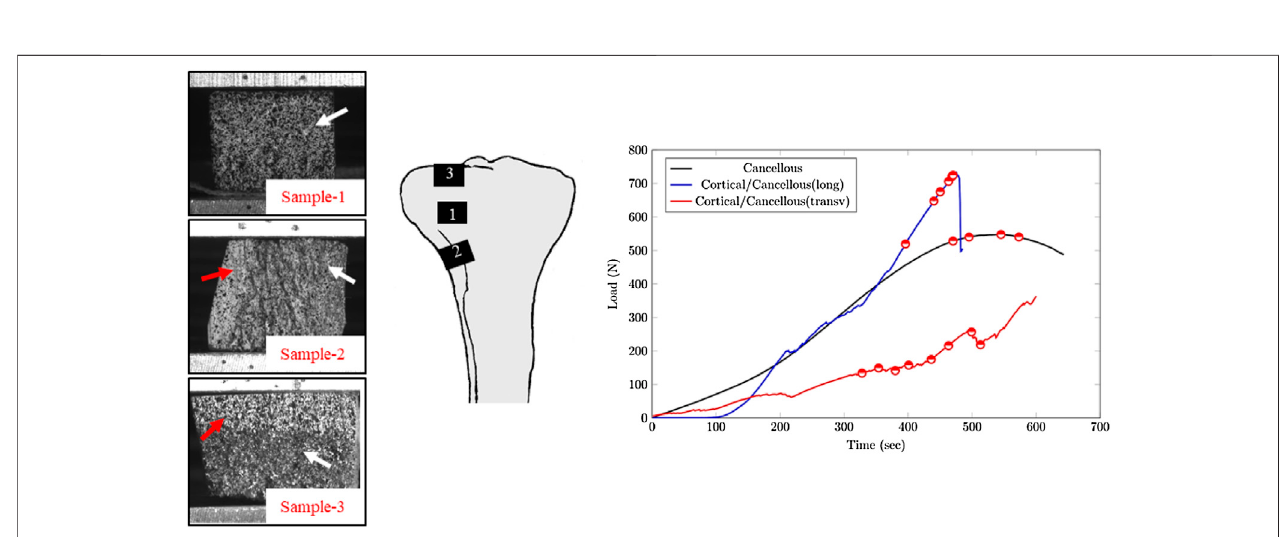
Frontiers in Bioengineering and Biotechnology |